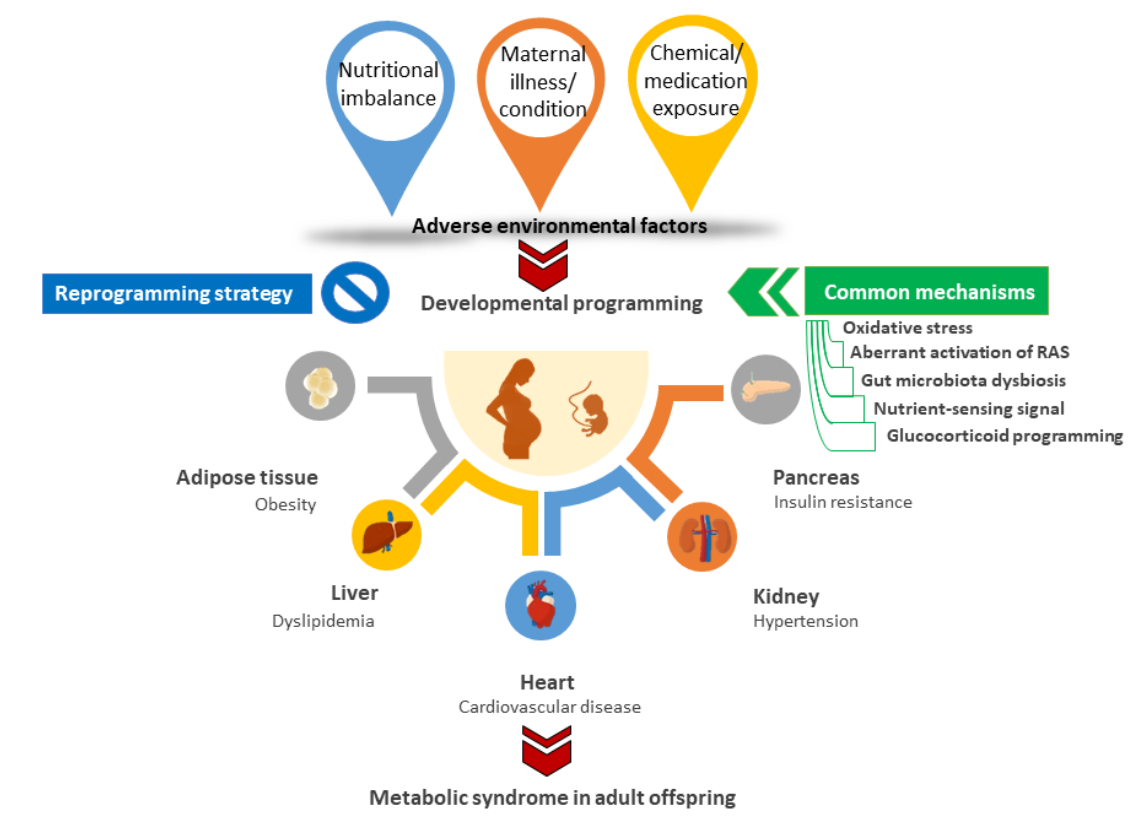
Figure 1. A schematic representation outlining the adverse environmental factors and potential mechanisms that may underlie the developmental programming in different organ systems resulting in metabolic syndrome in adulthood. By switching therapy from adulthood to early life before metabolic syndrome occurs by so-called reprogramming, we have the potential to prevent metabolic syndrome of developmental origins. RAS = renin-angiotensin system.